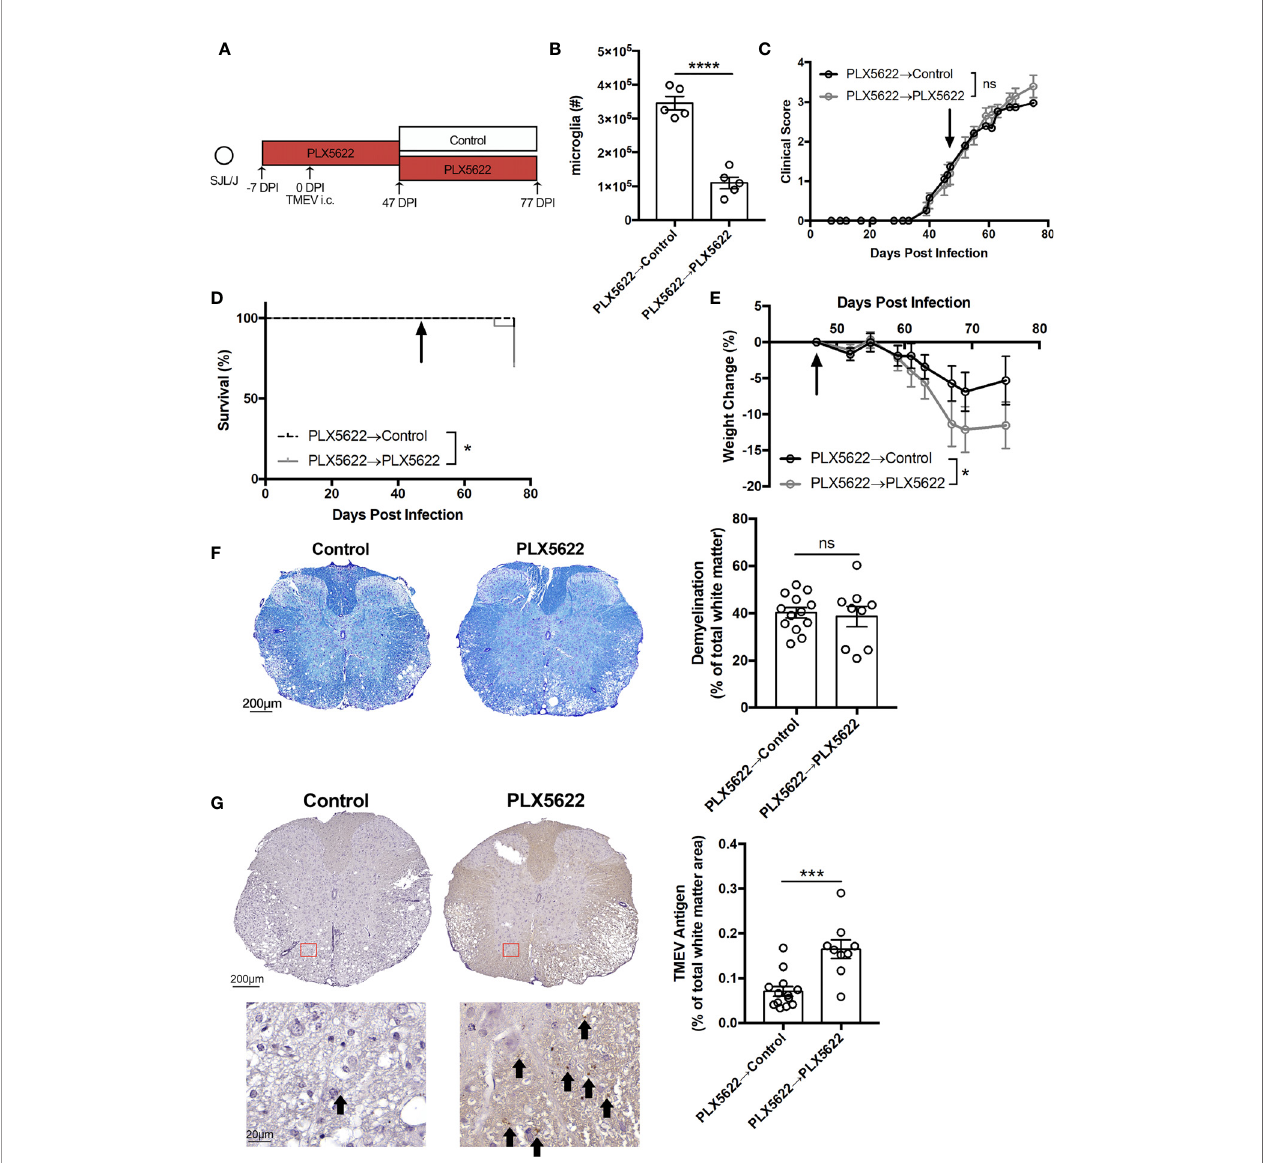
FIGURE 5 | Cessation of PLX5622 suppresses TMEV-associated pathology in microglia-de fi cient SJL/J mice. (A) SJL/J mice were treated with a PLX5622- supplemented diet seven days prior to i.c. TMEV infection, switched to a control diet or remained on the PLX5622-supplemented diet at 47 DPI, and were sacri fi ced at 77 DPI for analysis. (B) Number of microglia (n = 5 mice per group). (C) Clinical score, (D) survival, and (E) weight change corresponding to (A) (n = 20 mice per group). (F) Representative luxol fast blue staining and (G) TMEV antigen staining (arrows highlight positive staining) in thoracic spinal cord cross sections and quanti fi cation (n = at least 9 mice per group, at least 5 sections per mouse). Data are presented as mean ± SEM. *P ≤ 0.05, ***P ≤ 0.001, ****P ≤ 0.0001, ns, not signi fi cant; Student t test for (B, F, G) , log-rank test for (D) , and two-way ANOVA for (C, E)